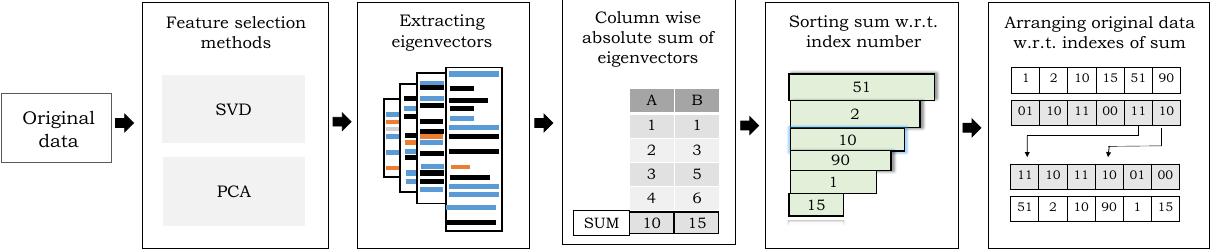
Figure 4. An overview of the feature selection process using subspace pooling